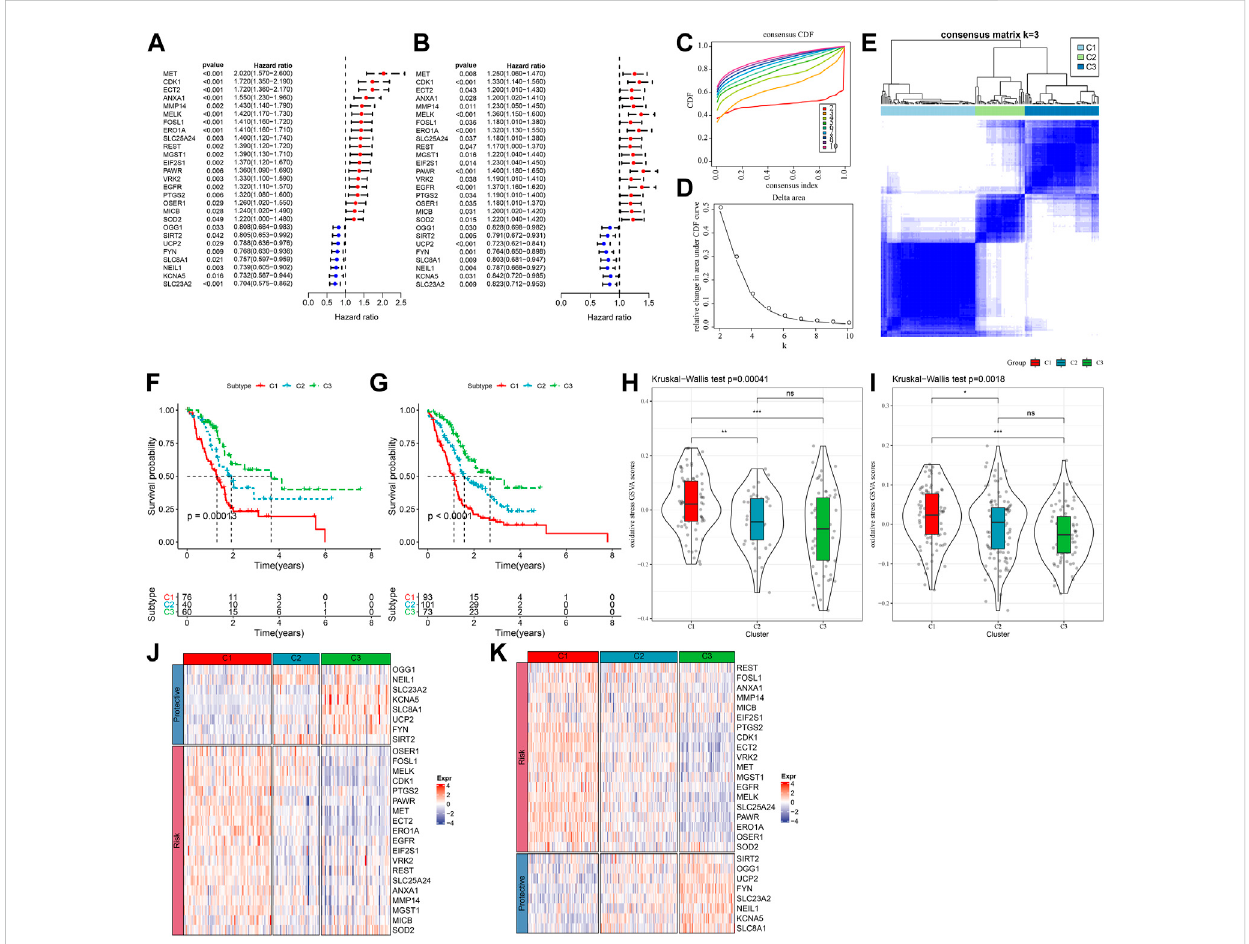
FIGURE 1 Three pancreatic cancer molecular subtypes based on oxidative stress-related genes. (A) In the TCGA-PAAD cohort, the forest plot of 27 prognostically signi fi cant oxidative stress genes; (B) The forest plot of 27 prognostically signi fi cant oxidative stress genes in the PACA-AU cohort; (C) CDF curves of TCGA-PAAD samples; (D) CDF Delta area curves of the samples, with the horizontal axis indicating the number of categories k and the verticalaxisindicatingtherelativechangeinareaundertheCDFcurve; (E) Atconsensusk=3,theheatmapofclusteredsamples; (F) KMcurveofthe prognosis of three subtypes of the TCGA-PAAD samples; (G) KM curve of the prognosis of three subtypes of the PACA-AU samples; (H) Differences in “ oxidative stress ssGSEA scores ” among the TCGA-PAAD molecular subtypes; (I) Differences in “ oxidative stress ssGSEA scores ” among the